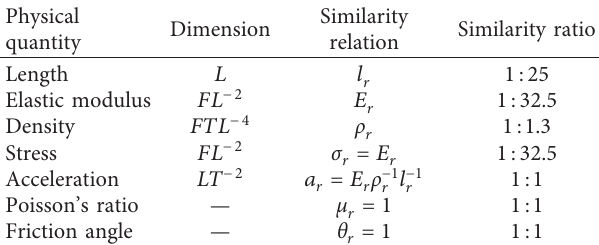
Figure 9: Frequency-domain analysis of acceleration of the Wuolong wave. Table 2: Similarity ratios of the shaking table